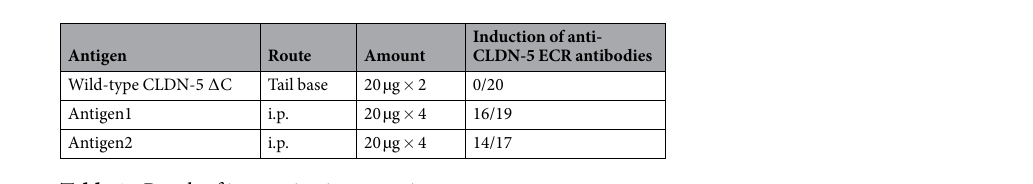
from the hybridomas and determined the amino acid sequences of their variable domains (Supplementary Fig. S1). The variable domain sequences were confirmed by reconstitution of the recombinant antibodies. We prepared cultured cells expressing human CLDN-1 through CLDN-7, as well as mouse CLDN-5, and investigated the reactivity of anti-CLDN-5 ECR mAbs to these cells using flow cytometry (Fig. 3). All five recombinant antibodies bound to the human CLDN-5-expressing cells. This result indicates that the antibodies were able to recognize and bind to the ECR of CLDN-5. They did not bind to any other human CLDNs. Among the mAbs, only clone 4F1 bound to mouse CLDN-5 orthologue. To fully investigate the subtype specificity of the anti-CLDN-5 ECR mAbs, we established a human CLDN library consisting of all 27 human CLDNs using the cell-free system, and conducted proteoliposome ELISA (Fig. 4). Four out of the five mAbs (all except 4F1) bound only to human CLDN-5, but not to other human CLDNs, demonstrating high subtype specificity. In contrast, clone 4F1 did not bind to any of the cell-free synthesized CLDN proteoliposomes including CLDN-5. There are several differences between cell-expression and cell-free synthesis 20 . For example, glycosylation does not occur in the wheat cell-free system because of the absence of the endoplasmic reticulum and Golgi apparatus in wheat germ extract. Reduced environment in the wheat cell-free